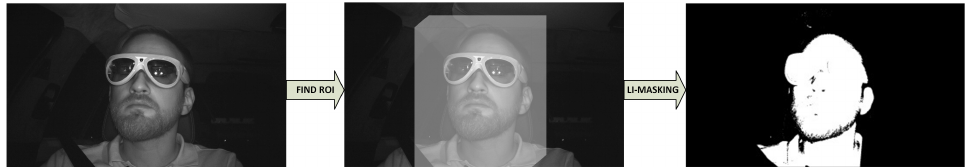
Figure 3. Mask generation pipeline. From left to right: determine region of interest based on projection of rendered cuboid and